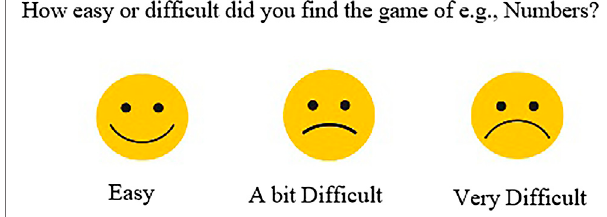
FIGURE 3 | Simpli fi ed cognitive load scale (a subjective rating scale). Three smiley faces were used to represent the children ’ s opinion (easy, a bit dif fi cult, and very dif fi cult) about the experienced cognitive load level imposed by the